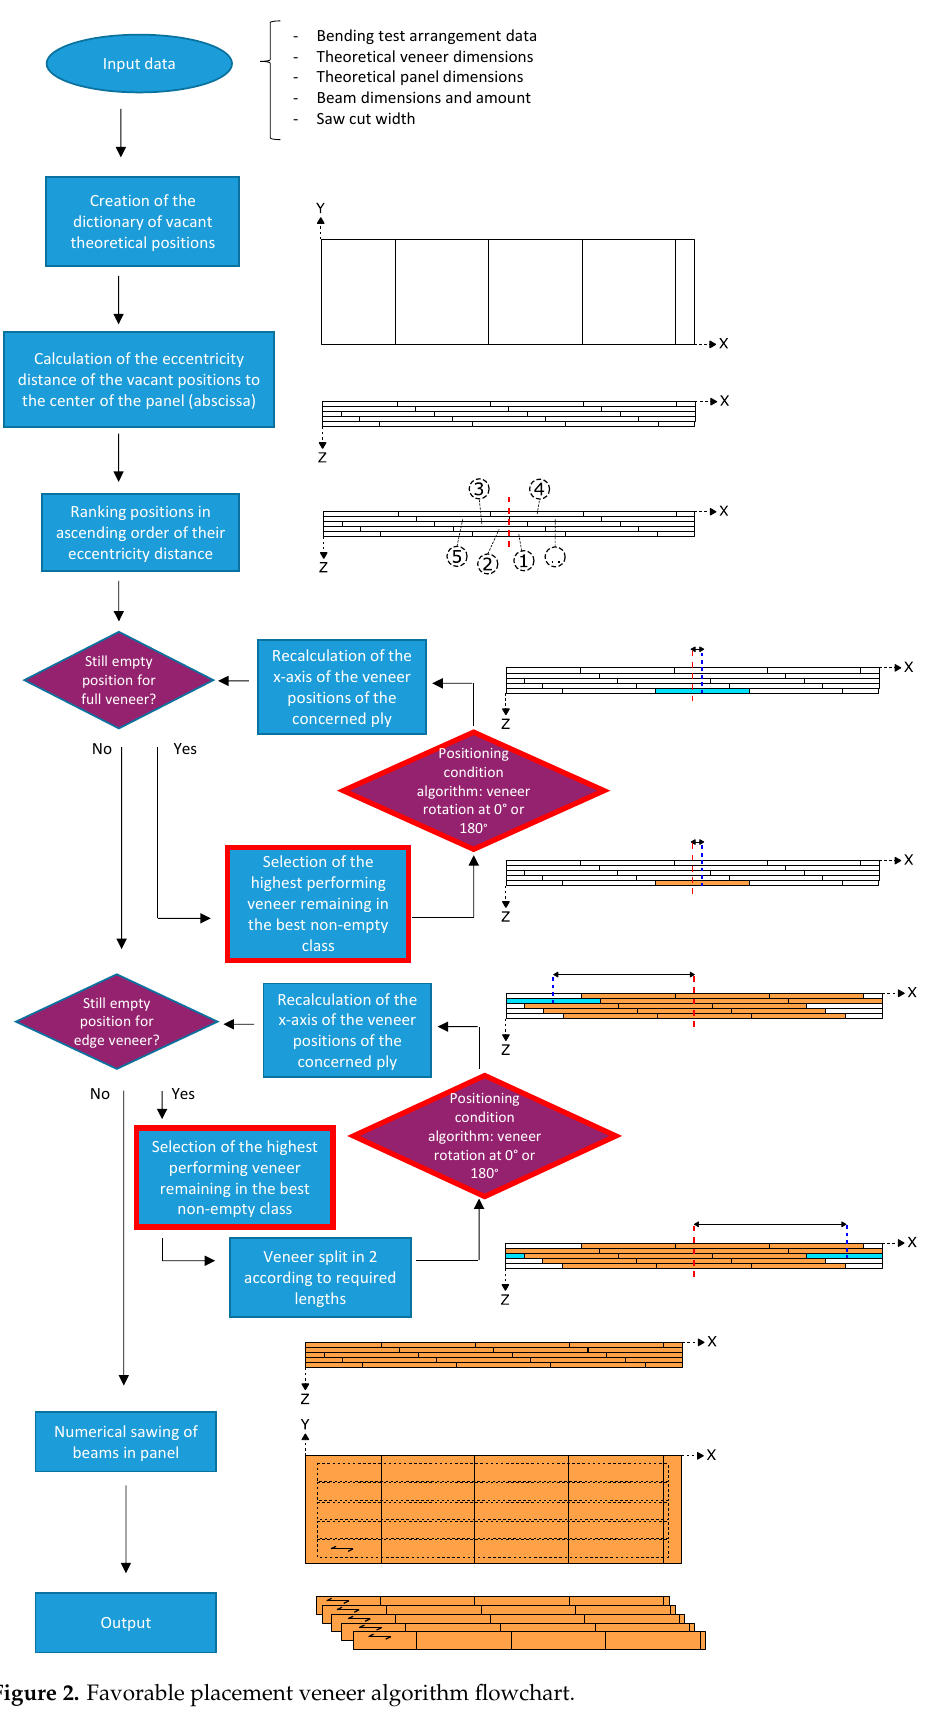
Figure 2. Favorable placement veneer algorithm flowchart.